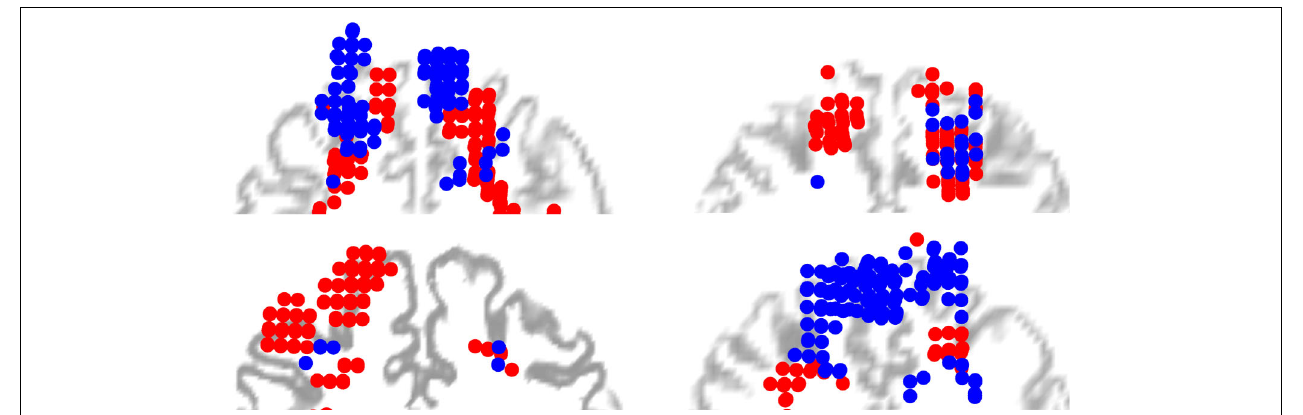
voxels to indicate their position with respect to the individual cerebral anatomy. Note that the distribution of selected FEF voxels entails 3 dimensions, and the T1 coronal section only 2. This projection is therefore only indicative of the course anatomical location of the voxels and does not exactly match sulcal